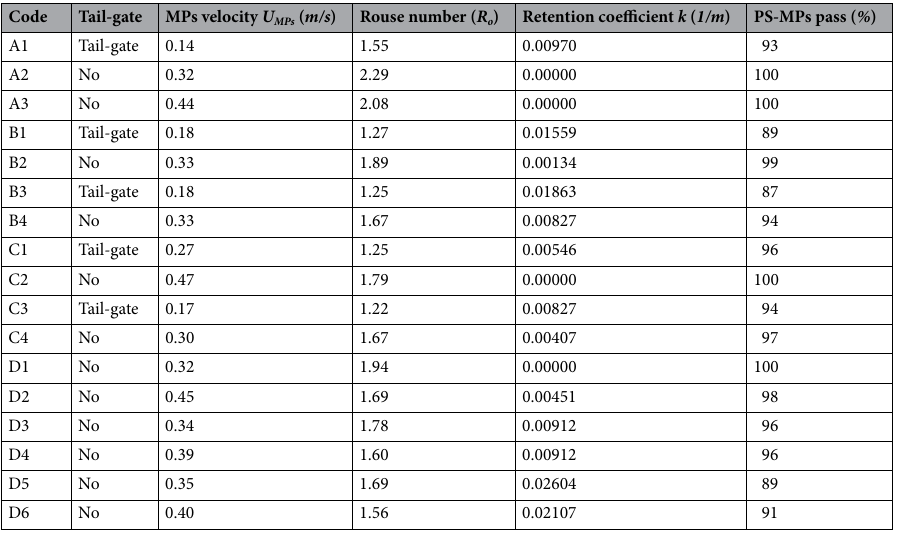
Table 2. Summary of key experimental results-